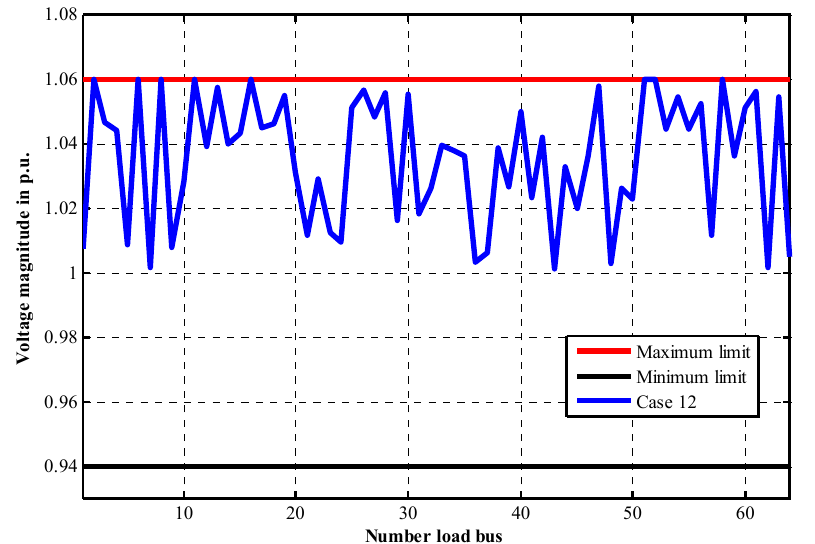
Figure 6. The voltage profile of Case 12.